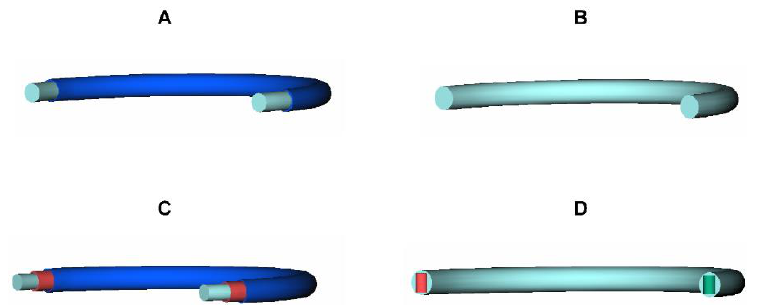
Figure 1. Di ff erent IVR designs: ( A ) Reservoir-type with drug-loaded core and drug-free membrane; ( B ) Matrix-type with drug dispersed in the polymer matrix; ( C ) Sandwich-type with drug-free core, drug loaded layer and drug-free membrane; and ( D ) Pod-type IVR with drug-free ring backbone with di ff erent pods inserted.